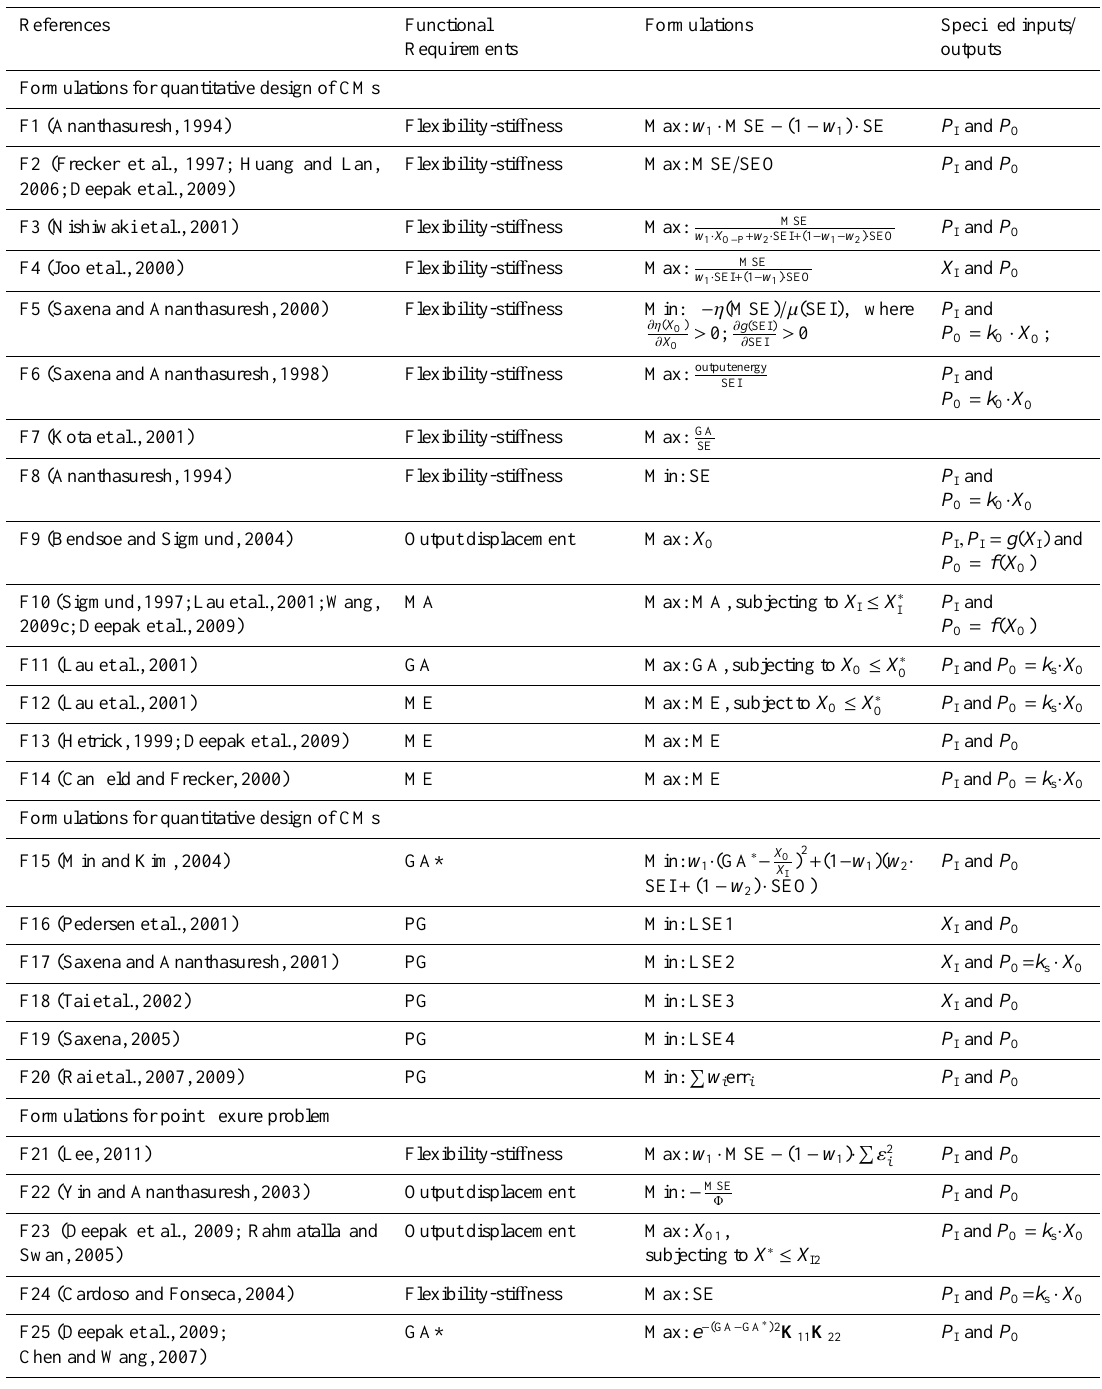
Table 2. Formulations in the